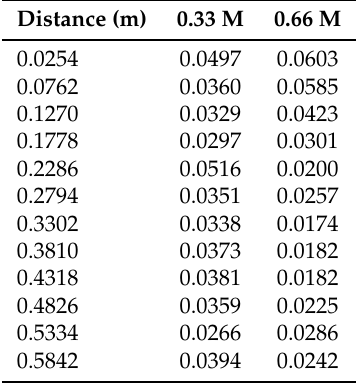
Table A2. Final calcite volume fraction distribution over column length of the 0.33 M and 0.66 M column experiments.